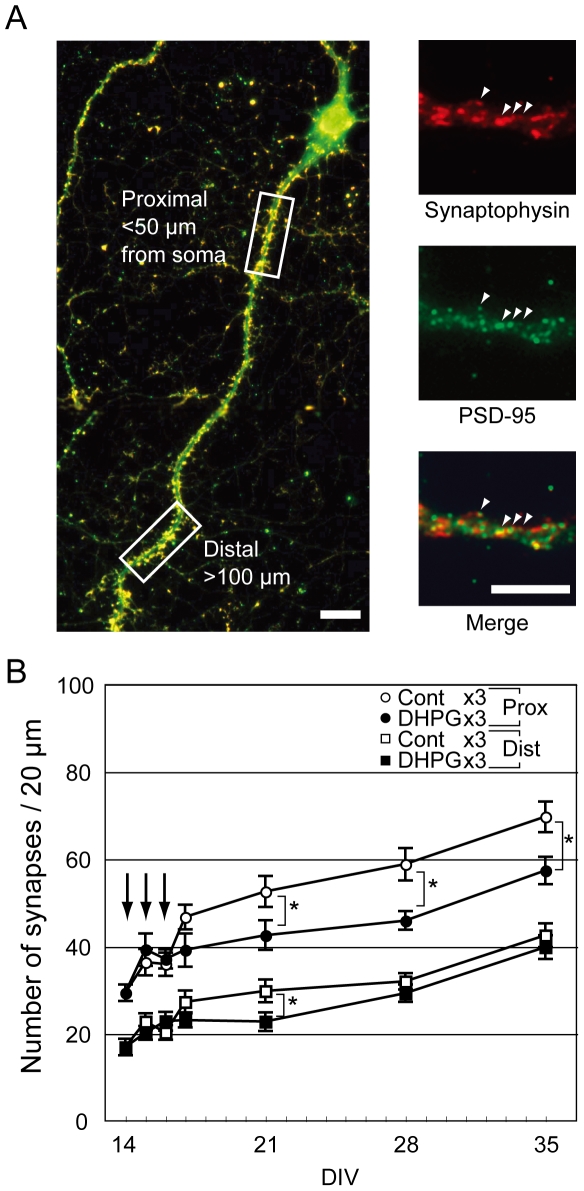
Time-dependent changes of synapse number after drug treatments.(A) Representative images of synaptophysin (red) and PSD-95 (green) immunostaining. The continual dendrite of a pyramidal neuron was divided into proximal and distal regions as determined by distance from soma (<50 µm and >100 µm, respectively). Two boxes indicate 20 µm regions of interest. Merged and apposed points of synaptophysin and PSD-95 immunopositive puncta were regarded as synapses (arrowheads). Scale bars indicate 10 µm. (B) Time-dependent changes of synapse number. Arrows indicate the days of drug application. In the proximal dendritic region, three applications of DHPG (filled circle) significantly reduced the numbers of developing synapses from one week after first drug application compared with control (open circle). In the distal region, although there was a significant difference between control (open square) and DHPG (filled square) groups at one week after first treatment, there was no persistent difference in number of synapses. The numbers of each experiment were indicated on top of each bar at DIV 14, 21, 28, and 35, respectively in all groups. Error bars indicate SEM; *p<0.05, Student's t-test.